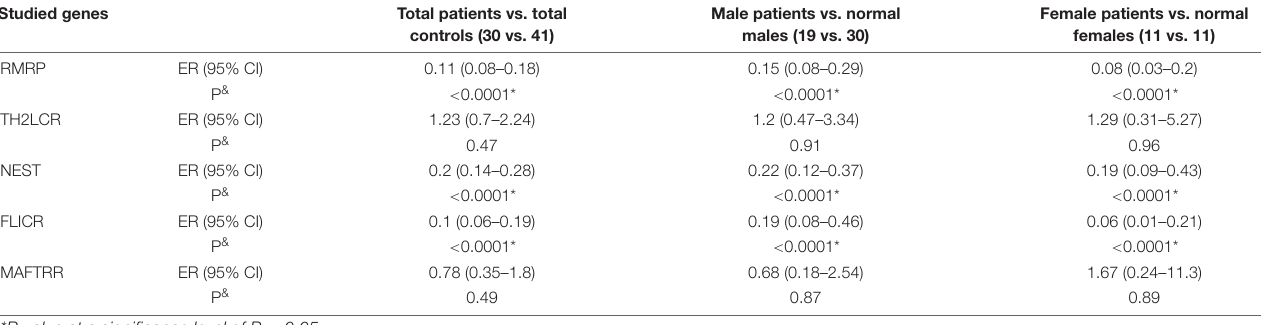
TABLE 3 | The results of the expression study of five Treg-related genes in peripheral blood of patients with ASD compared with healthy controls ( & , adjusted P -value, RE, expression ratio). Studied genes